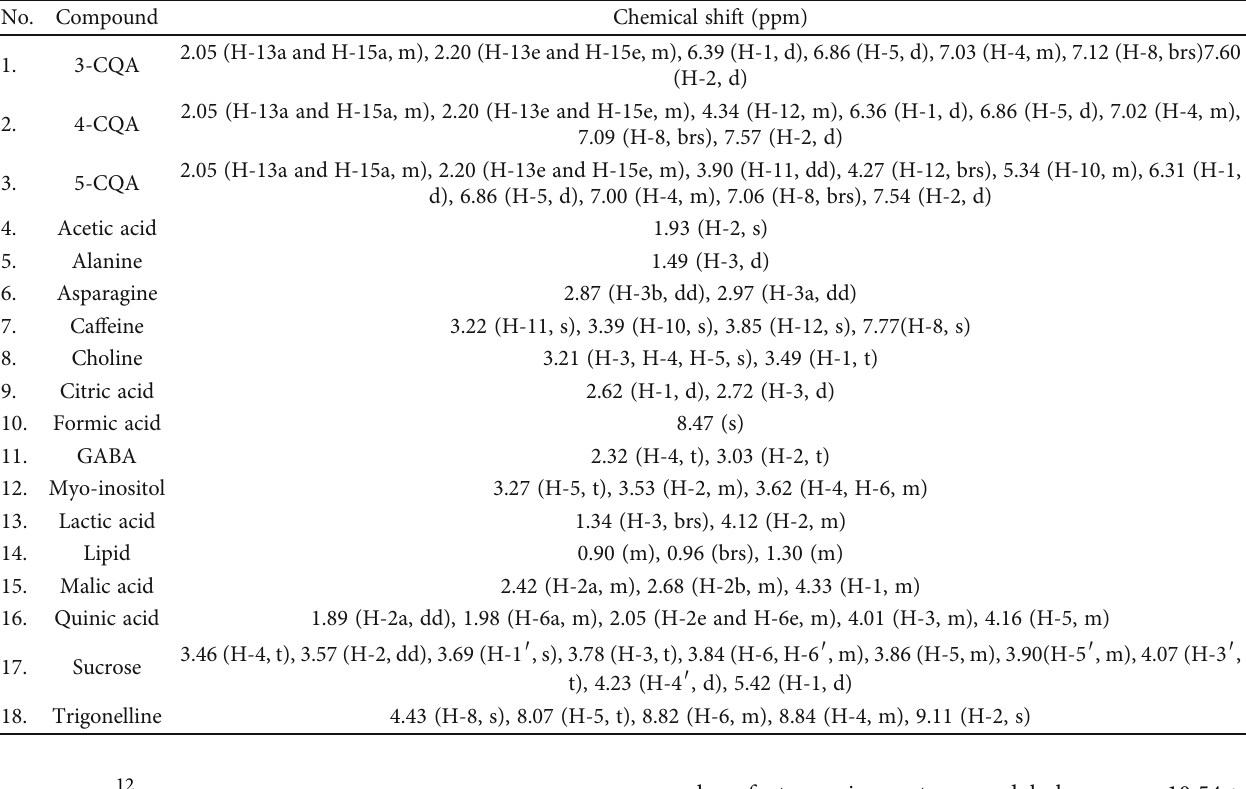
Table 1: Characteristic 1 H NMR signals of the identi fi ed compounds.